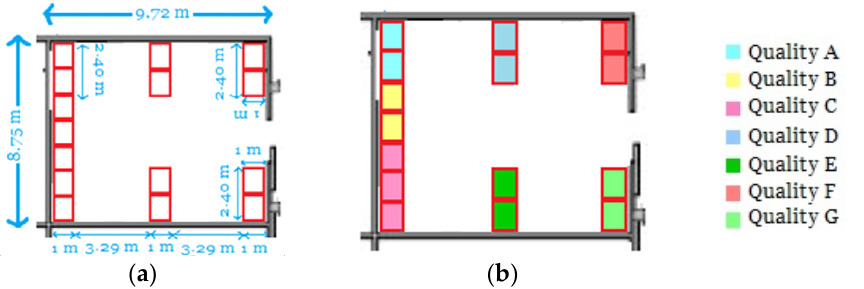
Figure 9. ( a , b ) New layout of the cold room for the raw material. Knowing that the organization works with 7 varieties of peaches, one of the solutions would be to create parallel rows of 2 pallet boxes according to variety and day of entry into storage, represented in (b). This new arrangement would not only allow 182 pallet boxes to be placed in the chamber, organized according to quality and day of reception, but also allow any employee to easily identify which pallet should be loaded into the sorting machine. This process would be made easier with the help of the optical readers suggested above, and the FIFO criterion would be respected. In relation to the empty pallets, each has a dimension of 1200 × 800 × 144 mm (1382 m 3 ). In this case, it is suggested that the storage be organized depending on the caliber, as illustrated in Figure 10.